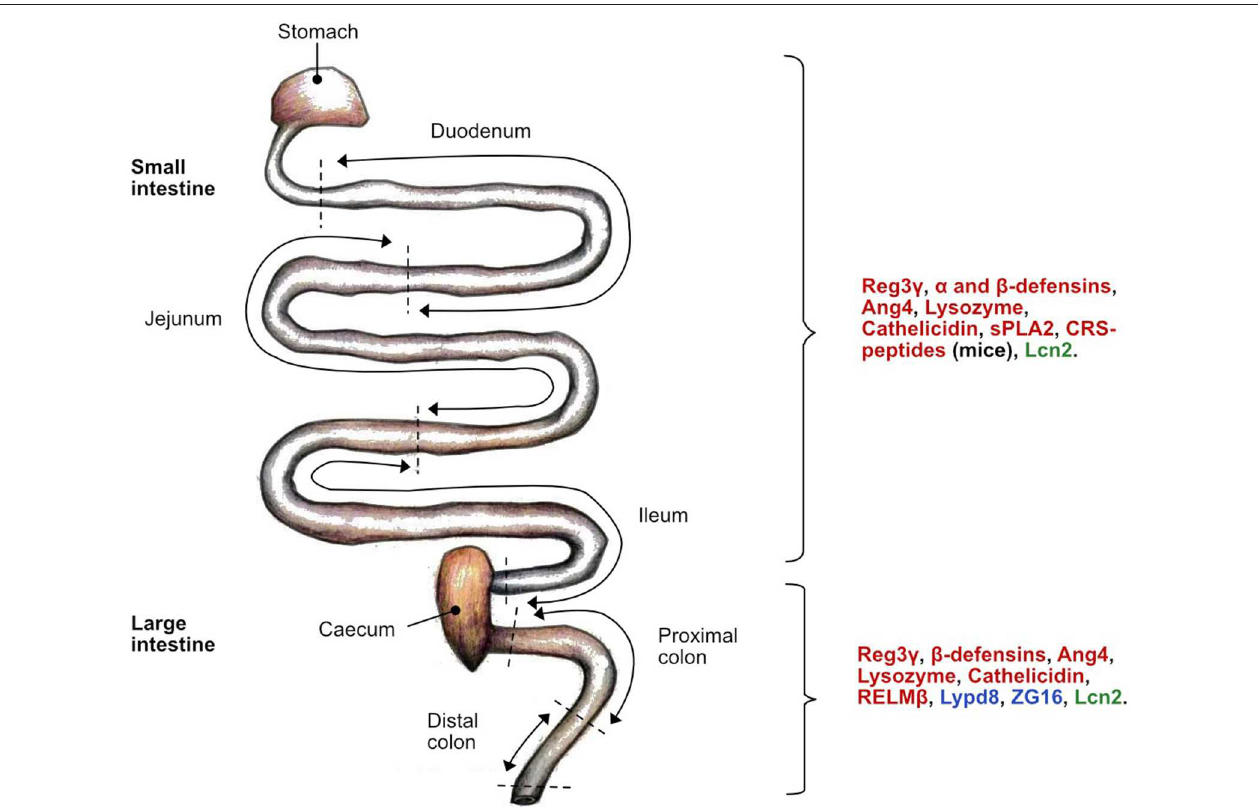
FIGURE 3 | Location of host defense peptide (HDP) expression along the mice intestine under normal physiological conditions. The antimicrobial activity is specific to each HDP class: bactericidal (red), bacteriostatic (green) and aggregation (blue). α -defensins can also be referred to as Defas in mice. C-type lectin regenerating islet-derived protein 3 gamma (Reg3 γ ); Angiogenin 4 (Ang4); secretory phospholipase A2 group IIA (sPLA2); cryptdin-related sequence peptides (CRS-peptide)s; Lipocalin-2 (Lcn2); Ly6/PLAUR domain containing 8 protein (Lypd8); zymogen granule protein 16 (ZG16); resistin-like molecule beta (RELM β